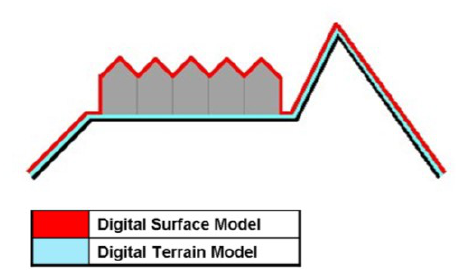
Figure 1: The difference between Digital Terrain Model (DTM) and Digital Surface Model (DSM) (Cetl, 2013)